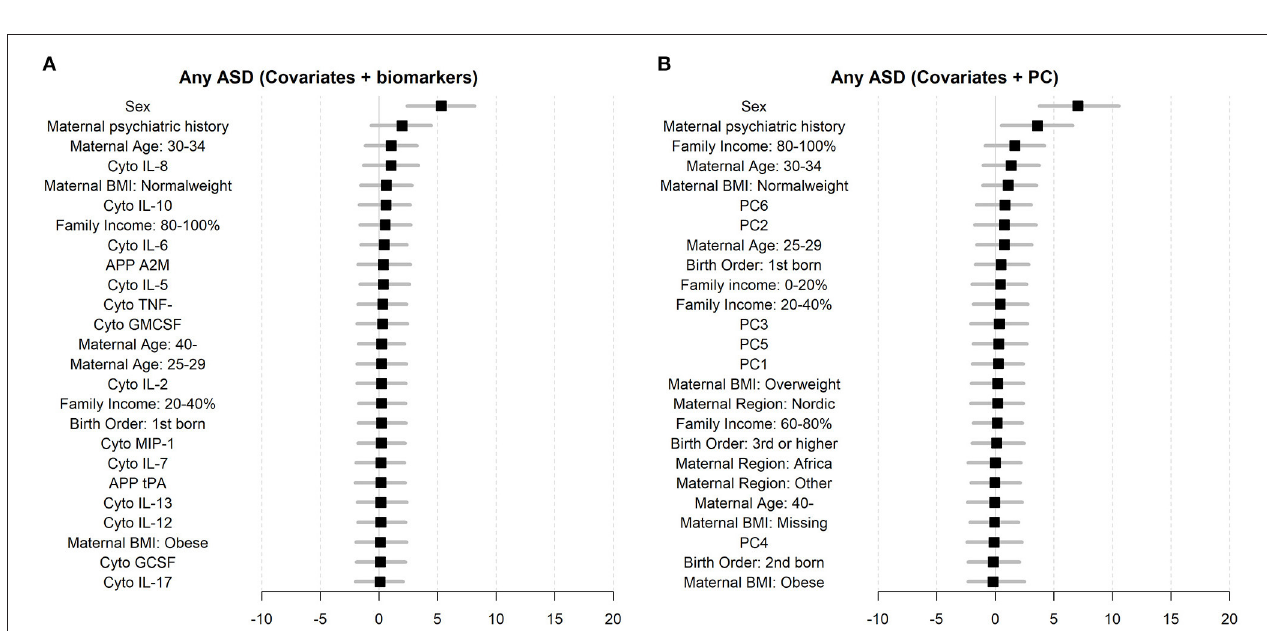
FIGURE 5 | The distribution of prediction accuracies of Random Forest prediction models, including the non-biomarker (i.e., register) covariates used in the fully adjusted regression models (sex of fetus; family income quintile; maternal education, BMI, psychiatric history, region of origin, and age), and adding the original cytokine and APP z-score variables (A) , or the four largest principal components (B) .